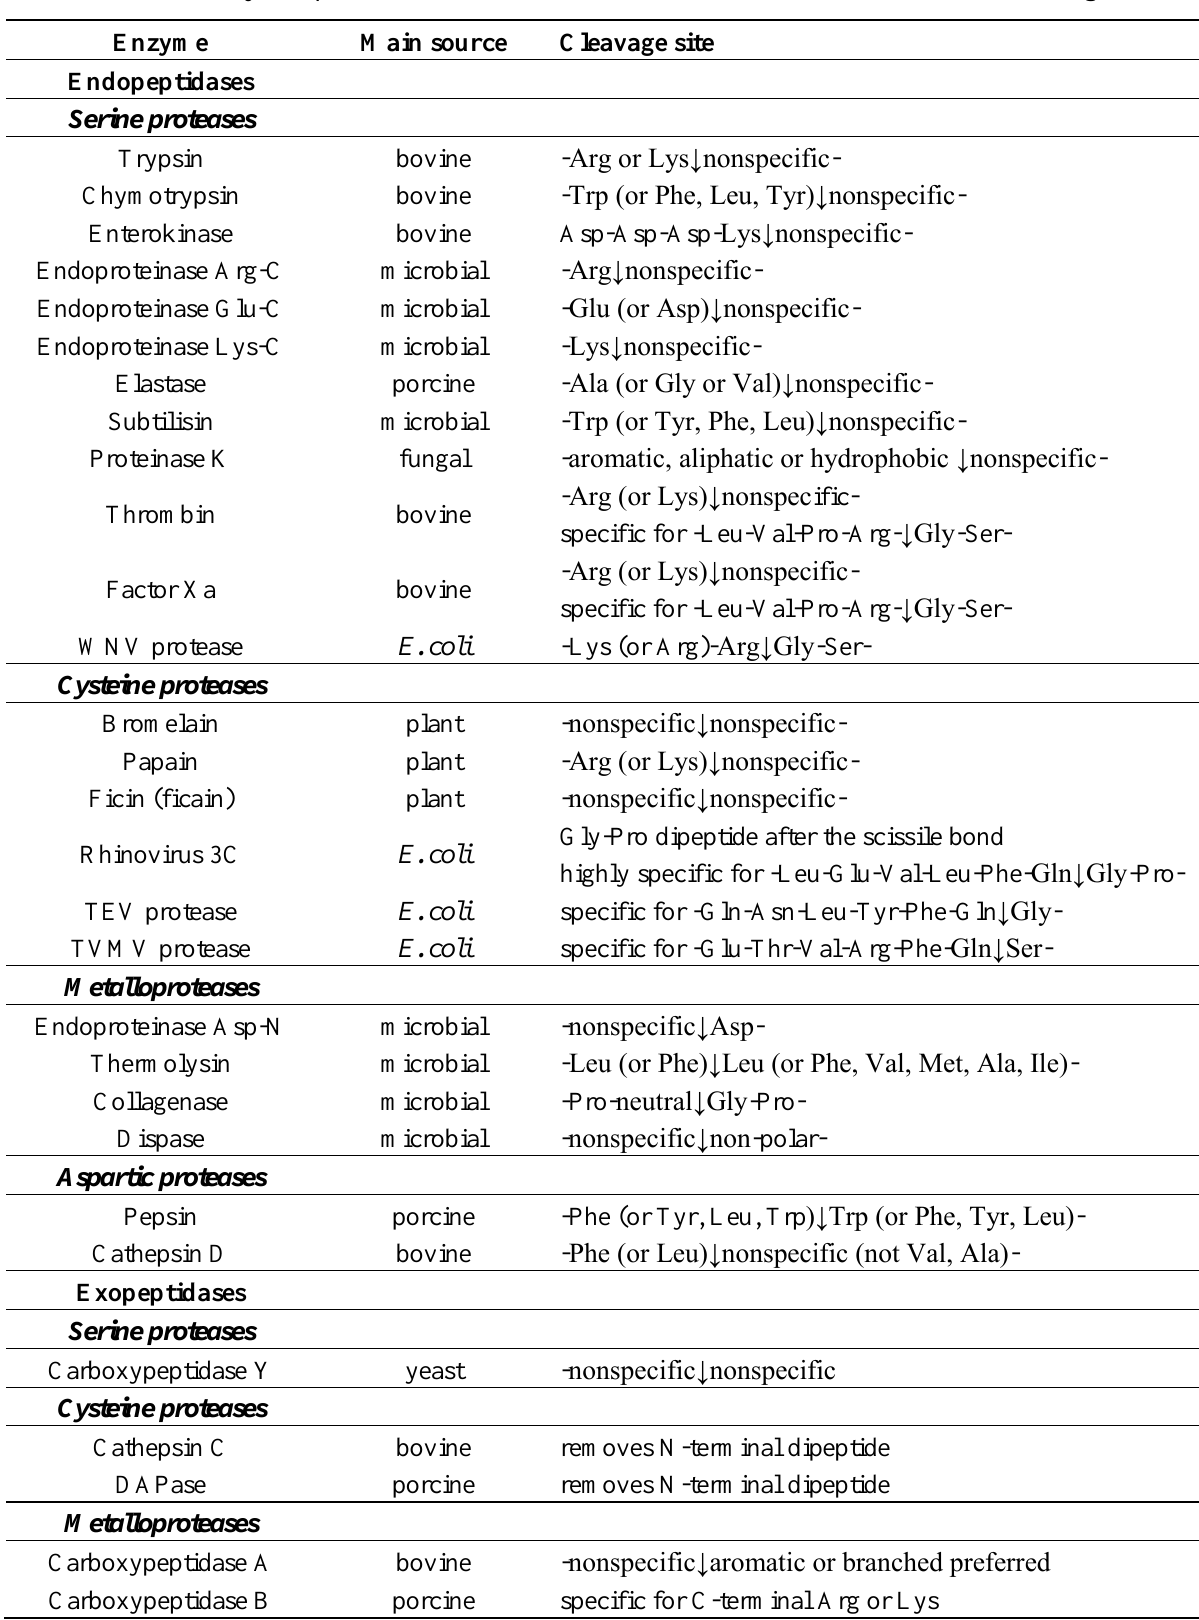
Table 1. Substrate specificity of some proteolytic enzymes used in molecular biology research. Proteases are classified based on their catalytic mechanisms, furthermore, the main sources and enzyme specificities are indicated. The arrows indicate the sites of